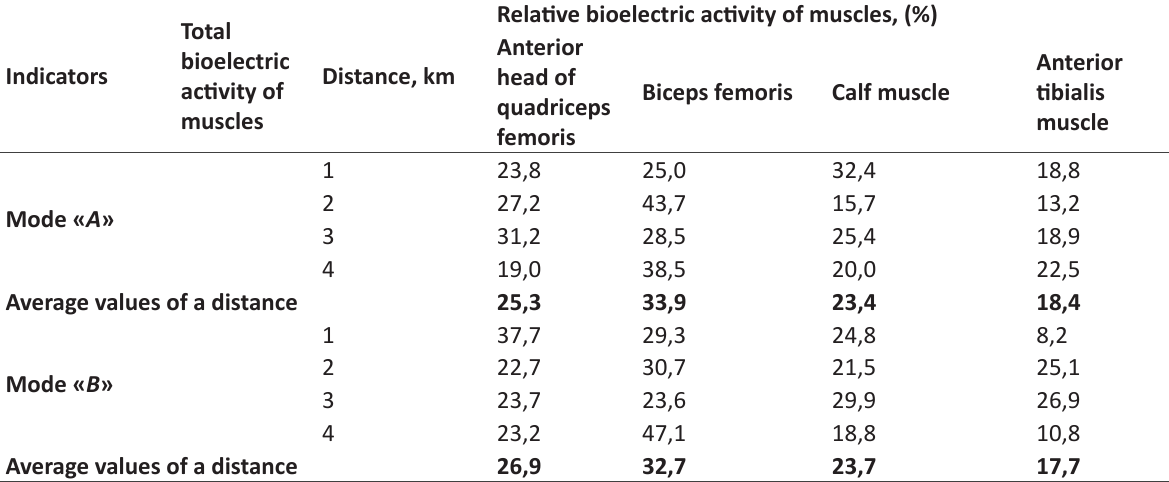
Table 3 . Dynamics of indicators of bioelectric activity of muscles in a pedalling cycle during passing a 4 km distance, X±m)